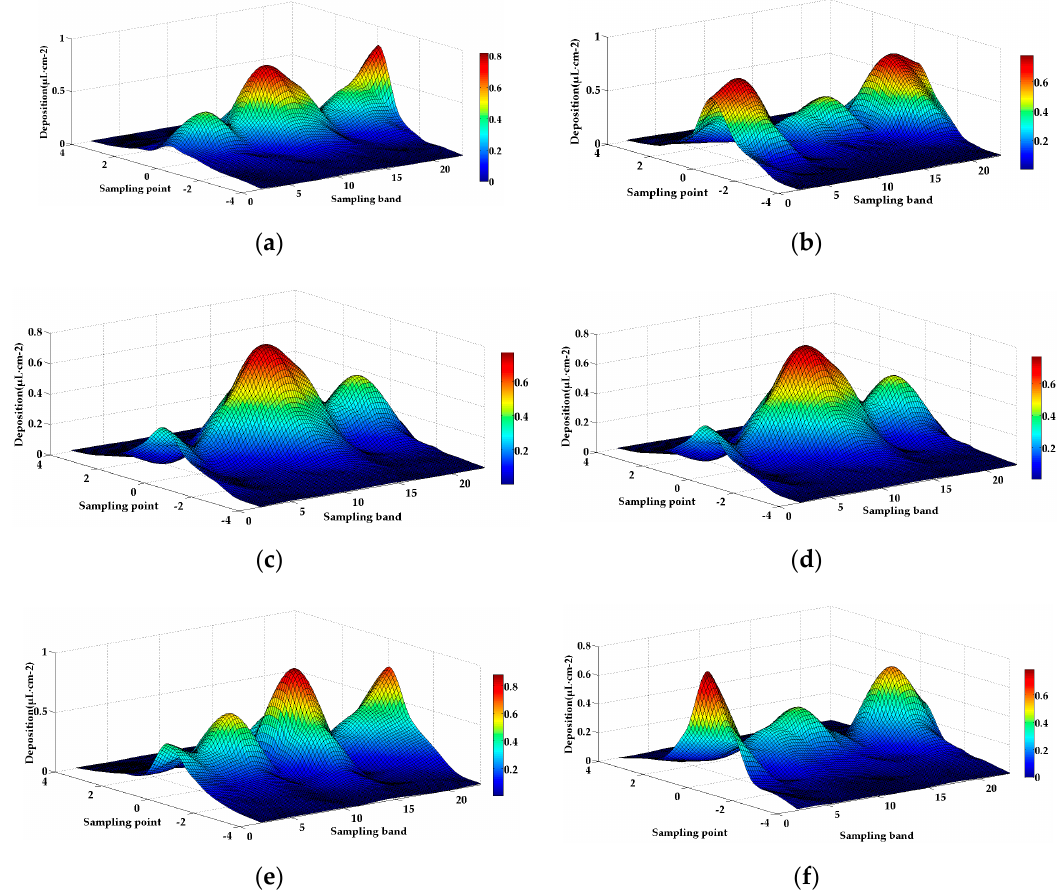
Figure 19. Fourth test of the droplet deposition amount of operating units on different routes. ( a ) Route F1. ( b ) Route F2. ( c ) Route F3. ( d ) Route F4. ( e ) Route F5. ( f ) Route F6.